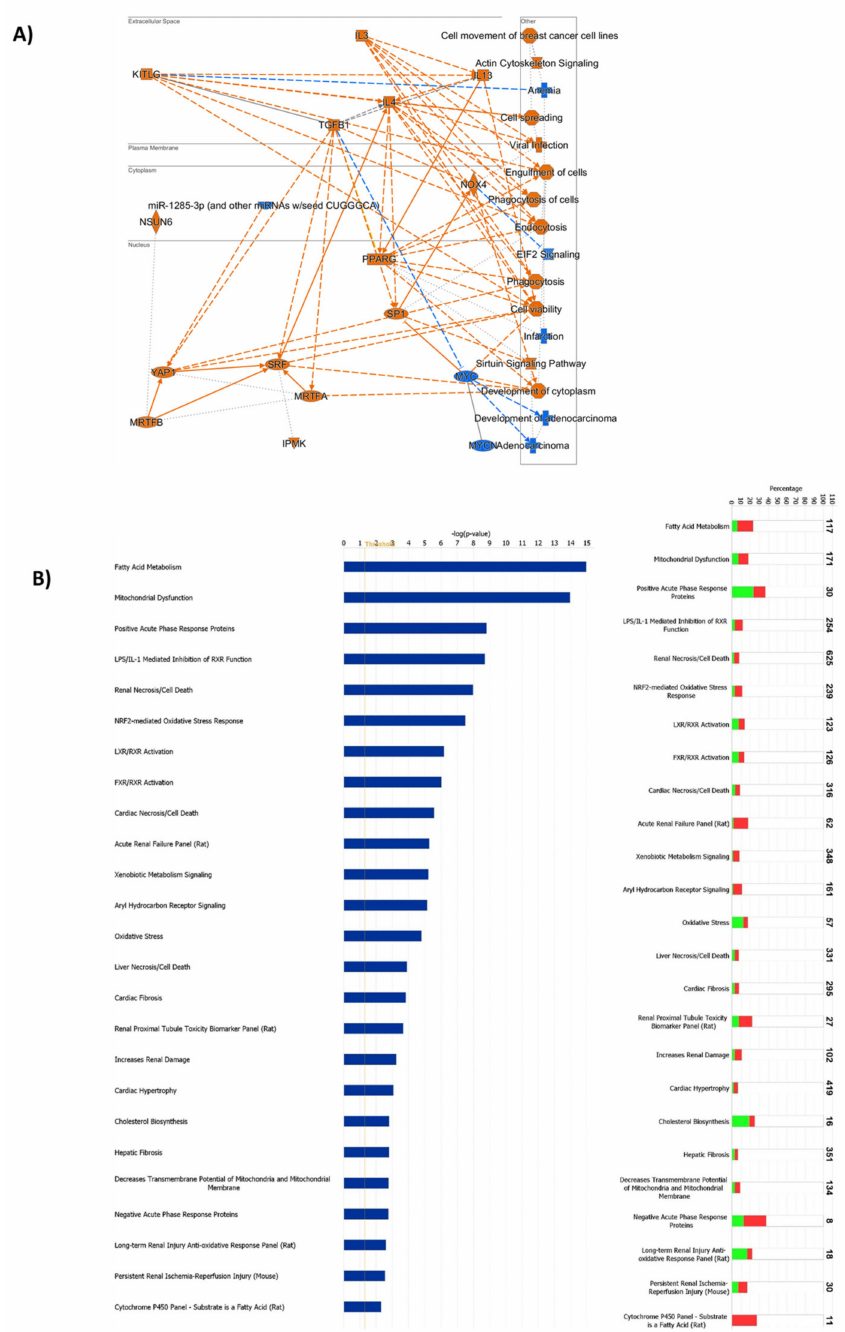
Figure 5. Bioinformatic analysis by Ingenuity Pathway Analysis (IPA) of the proteins differentially expressed in the comparisons between the high-fat and normal chow group. ( A ) Graphical summary of the bioinformatic analysis. Increased proteins/processes are indicated in orange and decreased proteins/processes are indicated in blue. ( B ) Toxicity list. For clarity, only the top 25 are indicated in the histograms. The histogram on the left reports the log p -value, and the significance threshold is indicated with the orange lane. The histogram on the right indicates the percentage of genes in our data set that are present in a specific cohort whose composition is indicated on top of each bar. Color code: red = upregulated proteins, green = downregulated proteins, white = no overlap with the data